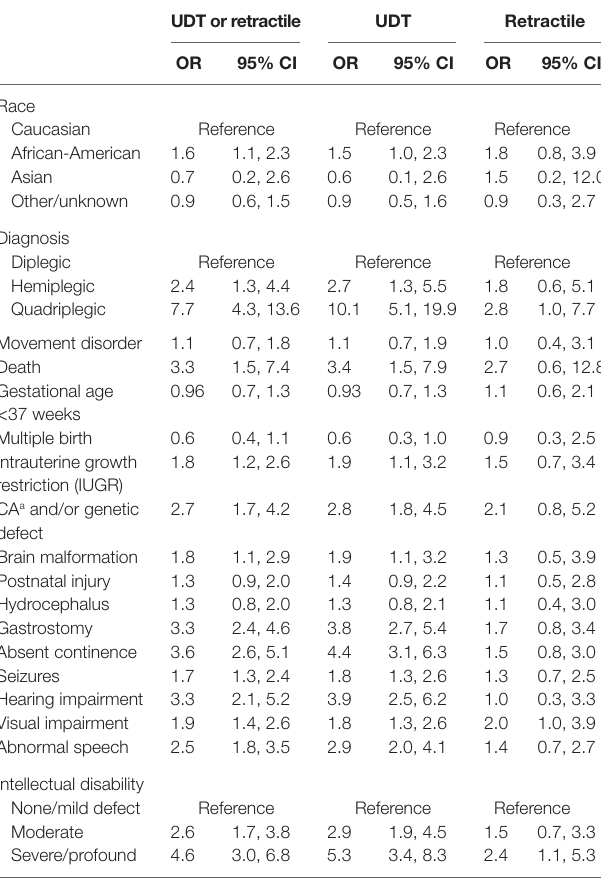
TaBle 4 | Stepwise logistic regression models to identify variables substantially associated with cryptorchidism subtype in boys with cerebral palsy. Variable Undescended or retractile Undescended testes testes Odds ratio (Or) (95% ci) Diagnosis Diplegia Reference